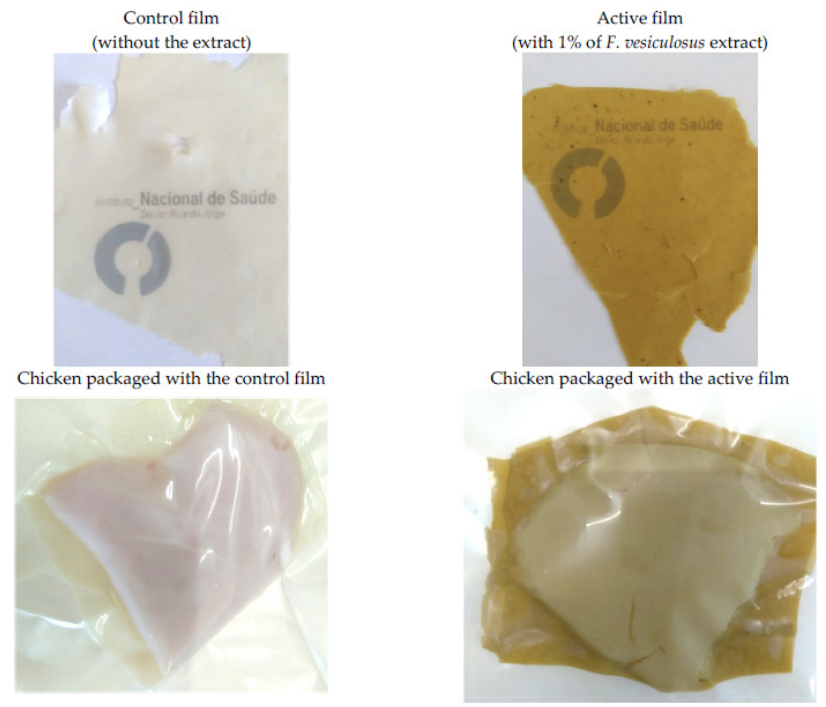
Figure 2. Whey protein control film and active film with 1% Fucus vesiculosus (brown seaweed) extract [29]. Table 2. Recent application of seaweed polysaccharides in active and intelligent packaging. Packaging